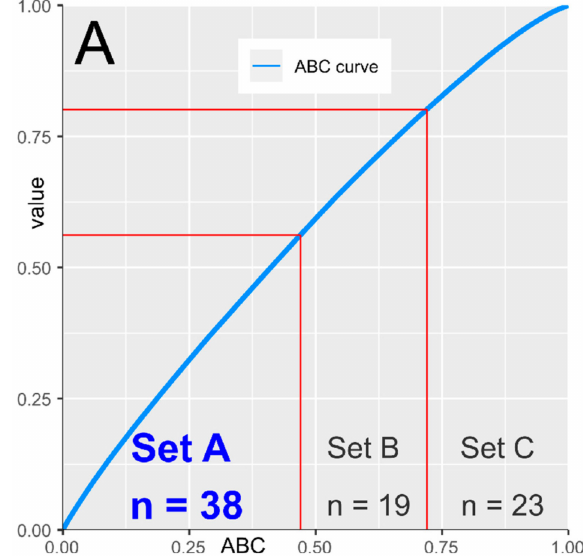
Figure 4. Identification of the most informative gene loci for pain phenotype class assignment using the computed ABC analysis. The mean decrease in classification accuracy associated with each genetic variant in the random forest analysis was submitted to ABC analysis, which is an item selection procedure aiming at the identification of the most profitable items from a larger list of items. The ABC plot (blue line) shows the cumulative distribution function of the mean decreases in accuracy (for further details about the computed ABC analysis, see [36]). The figure has been created using the R software package (v. 3.6.2 for Linux; http: // CRAN.R-project.org / [25]) and the R libraries “ABCanalysis” (http: // cran.r-project.org / package = ABCanalysis [36]) and “ggplot2” (https: // cran.r-project.org / package = ggplot2